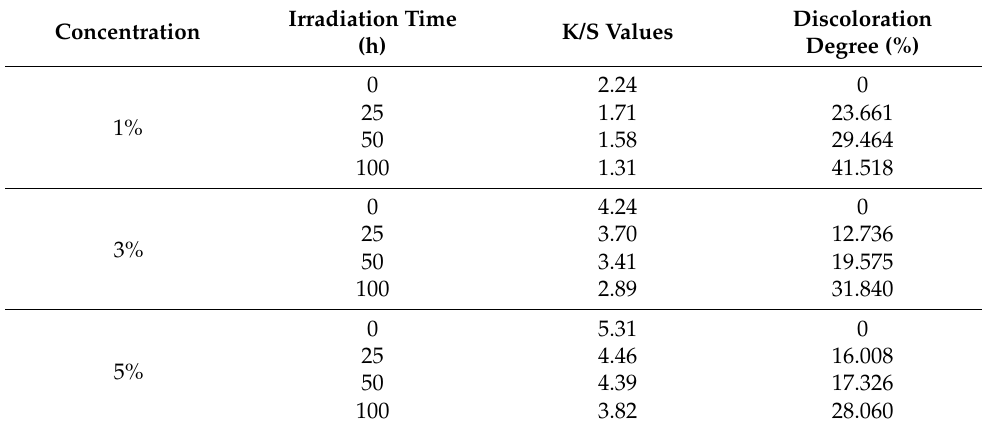
Table 3. Color intensity and discoloration degree of samples dyed with 1%, 3%, and 5% solution of reactive dye as a function of irradiation time irradiated in UV, measured at 636 nm. Concentration